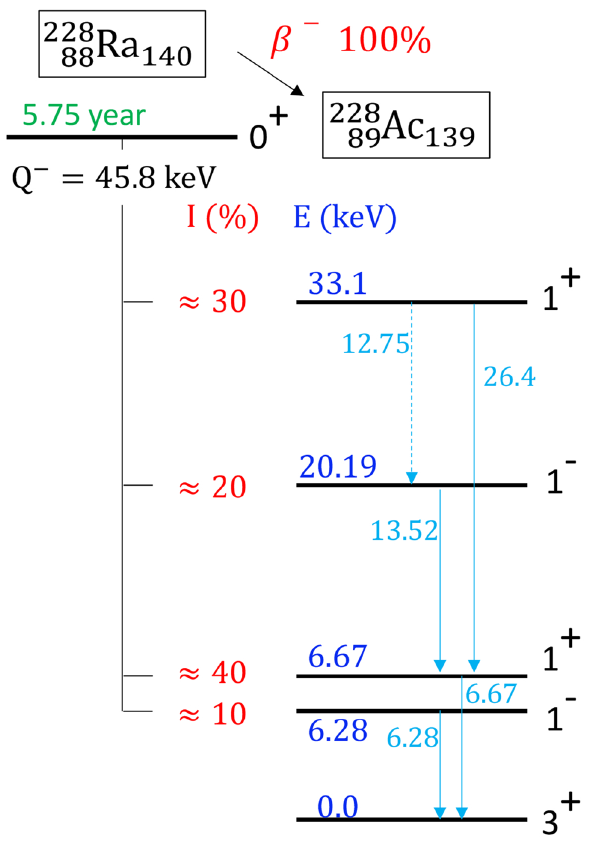
Fig. 1 Nuclear level scheme for 228 Ac adapted from Ref.